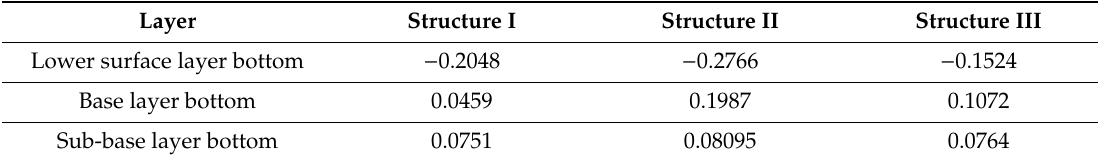
Table 5. Maximum tensile stress of key layers under the uniform load of single circle (unit: MPa). Layer Lower surface layer